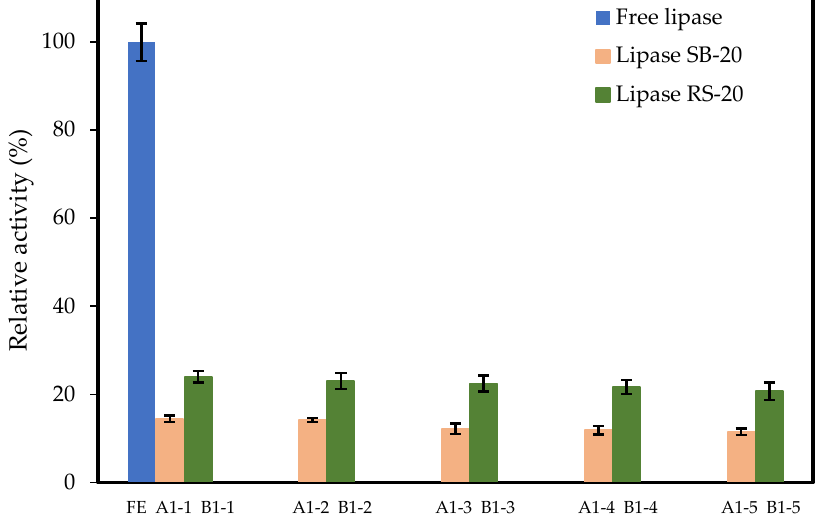
Figure 7. The activity of immobilized enzymes in various CNC modifications was relative to the activity of free enzymes. Activity testing was carried out at a temperature of 25 °C.